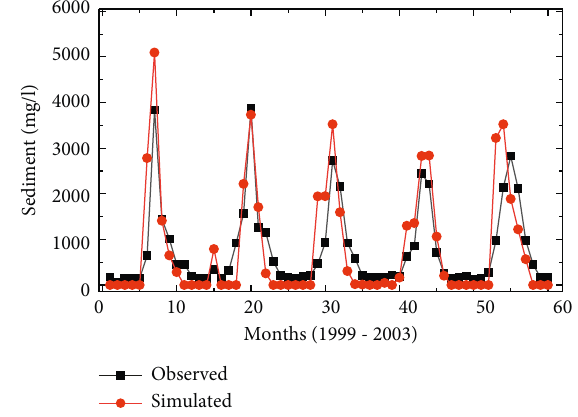
Figure 7: Observed and validated sediment.